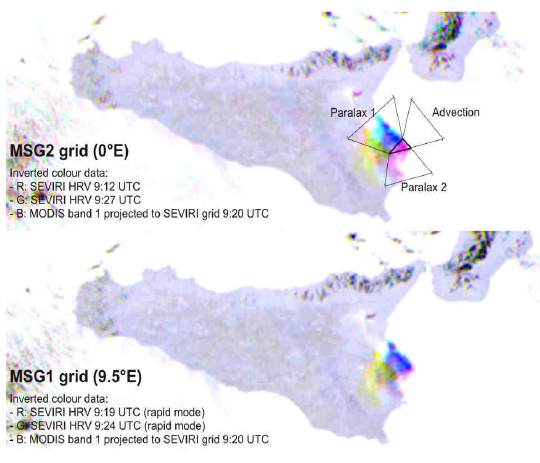
Figure 3. SEVIRI and MODIS data combined into RGB image; above data from 15 min SEVIRI retrieval on MSG2, below data from 5 min SEVIRI retrieval on MSG1.